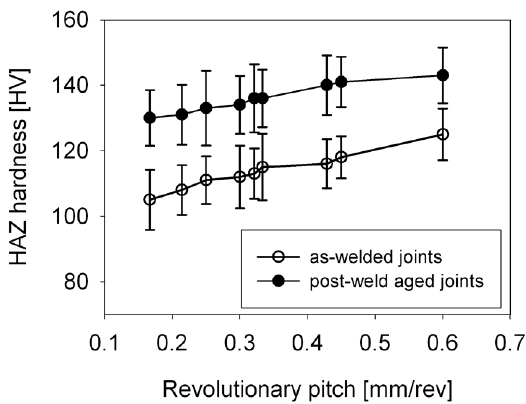
Figure 7. Hardness of the HAZ as function of the RP (median over four specimens, the 80% confidence limits are